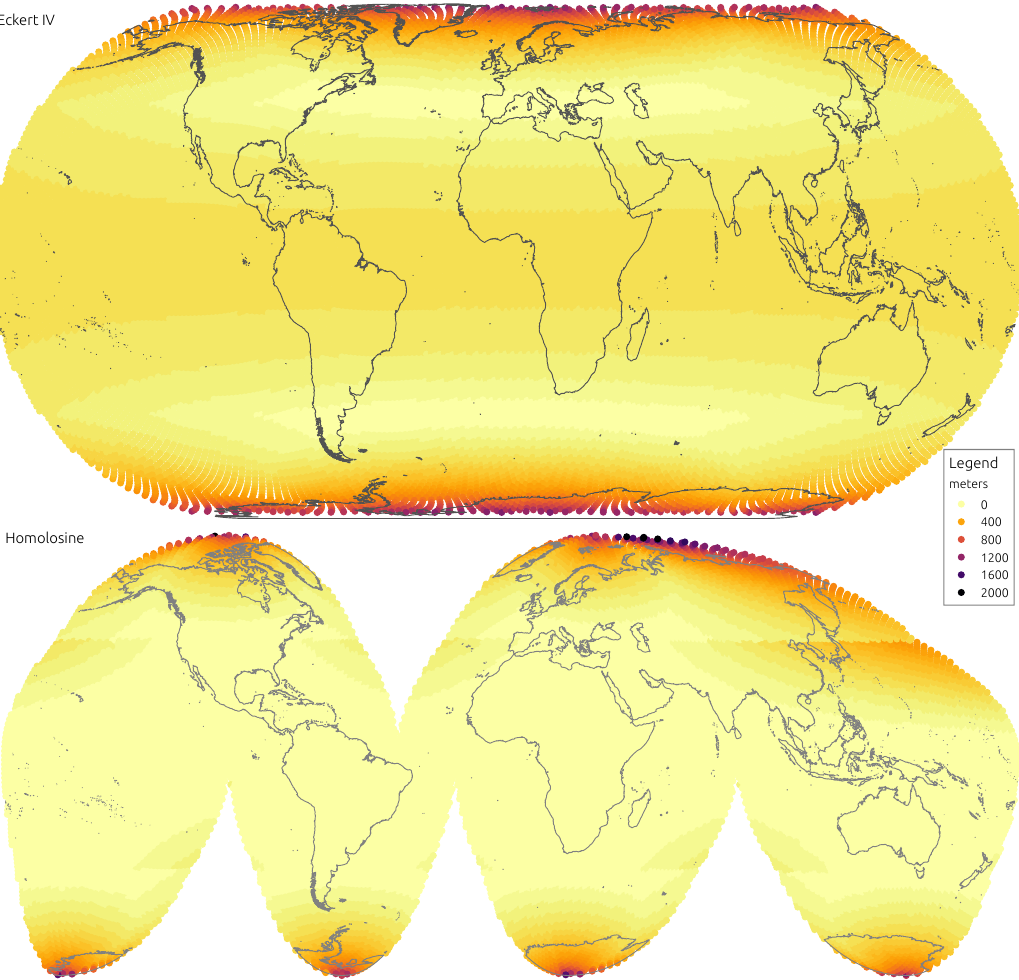
Figure 7. Mean absolute distance distortion at each indicatrix for the Eckert IV and Homolosine